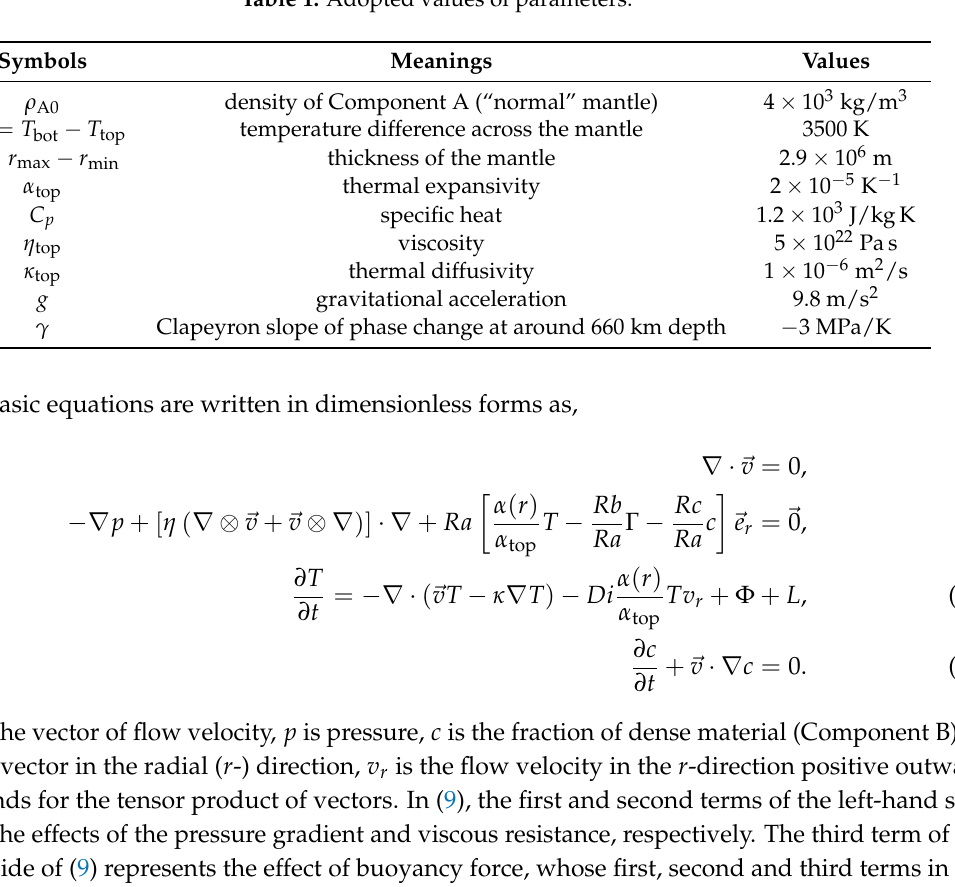
Table 1. Adopted values of